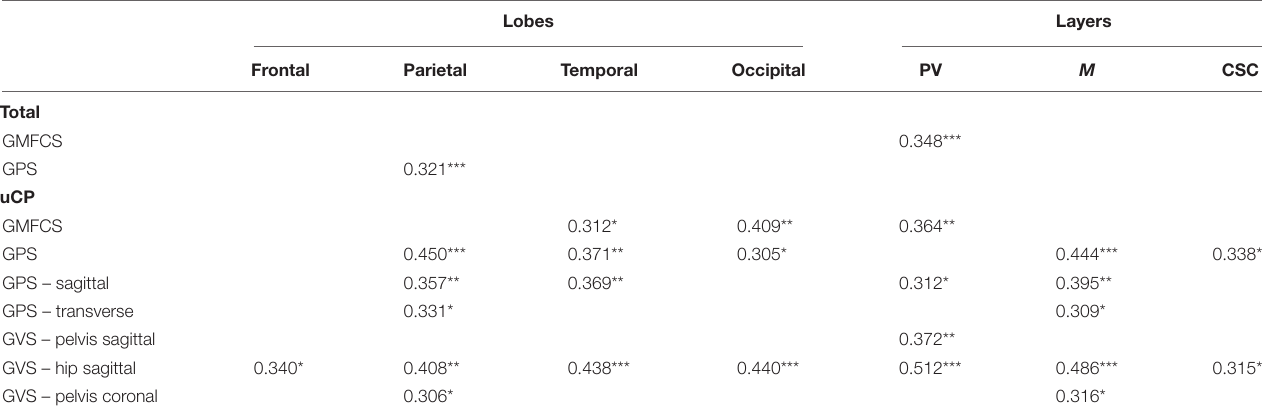
TABLE 2 | Spearman’s rank correlations between the sqMRI location scores of the most affected brain side and the scores of functional ability and gait for the total ( N = 104) and unilateral ( n = 52) groups. Lobes